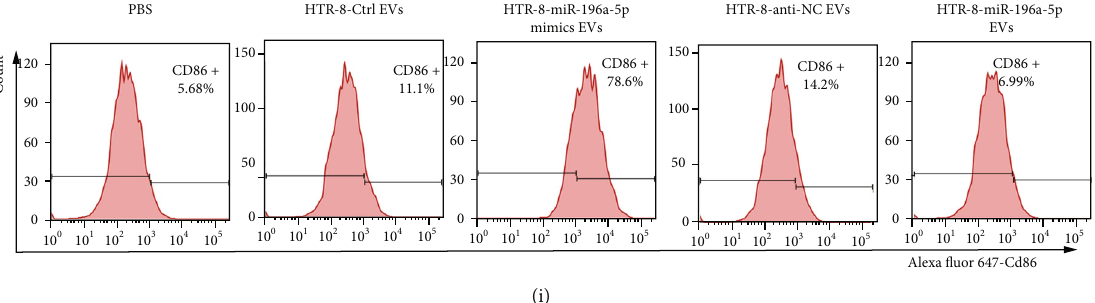
Figure 3: Trophoblast-derived EV miR-196a-5p promotes M1 polarization of macrophages. (a) Morphology of THP-1 cells treated with PMA for 24 h (left) and qPCR analysis of the expression levels of the macrophage marker, CD68 (right). (b) Immuno fl uorescence images demonstrating the internalization of DiO-labeled HTR-8-derived EVs (green) by PMA-treated THP-1 cells. (c, d) PMA-pretreated THP- 1 cells were transfected with miR-196a-5p mimics, and (c) the expression of miR-196a-5p and (d) the expression of typical markers of M1 and M2 macrophages were determined using qPCR. (e) CD86-positive cell count (M1 marker) in the PMA-pretreated THP-1 cells after transfection with miR-196a-5p mimics was detected using fl ow cytometry. (f, g) HTR-8 cells were transfected with miR-196a-5p mimics, anti-miR-196a-5p, or their respective controls, and the expression levels of miR-196a-5p in HTR-8 cells and HTR-8 derived-EVs were measured using qPCR. PMA-pretreated THP-1 cells were treated with EVs derived from the miR-196a-5p overexpressing or knockdown HTR-8 cells, as well as from their respective controls. (h) qPCR analysis of the expression levels of M1 markers (black ∗ : HTR-8-Ctrl EVs vs. PBS; yellow: HTR-8-miR-196a-5p mimics EVs vs. HTR-8-Ctrl EVs; green ∗ : HTR-8-anti-miR-196a-5p EVs vs. HTR- 8-anti-NC EVs). (i) CD86-positive cell count was determined using fl ow cytometry ( ∗ p < 0 : 05 ; ∗∗ p < 0 : 01 ; ∗∗∗ p < 0 : 001 ). EV: extracellular vesicle; PMA: phorbol 12-myristate